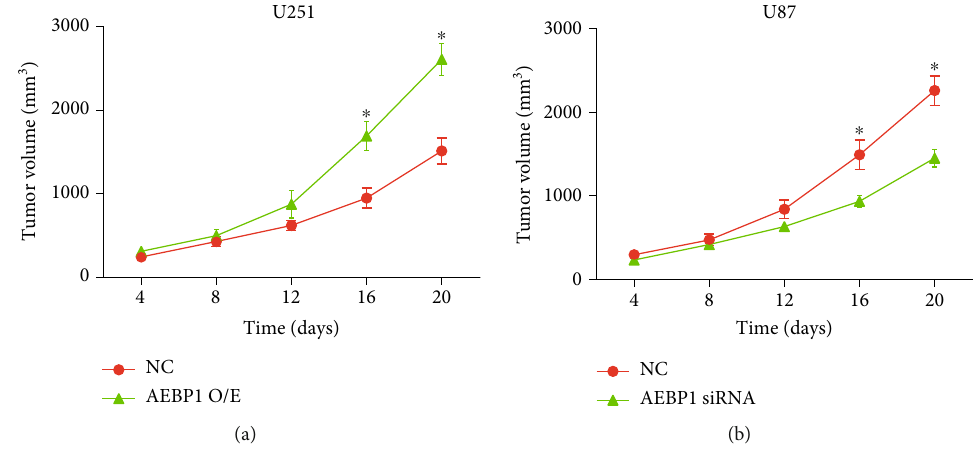
Figure 6: AEBP1 promoted the growth of GBM tumors in vivo. N = 3 , ∗ P < 0 : 05